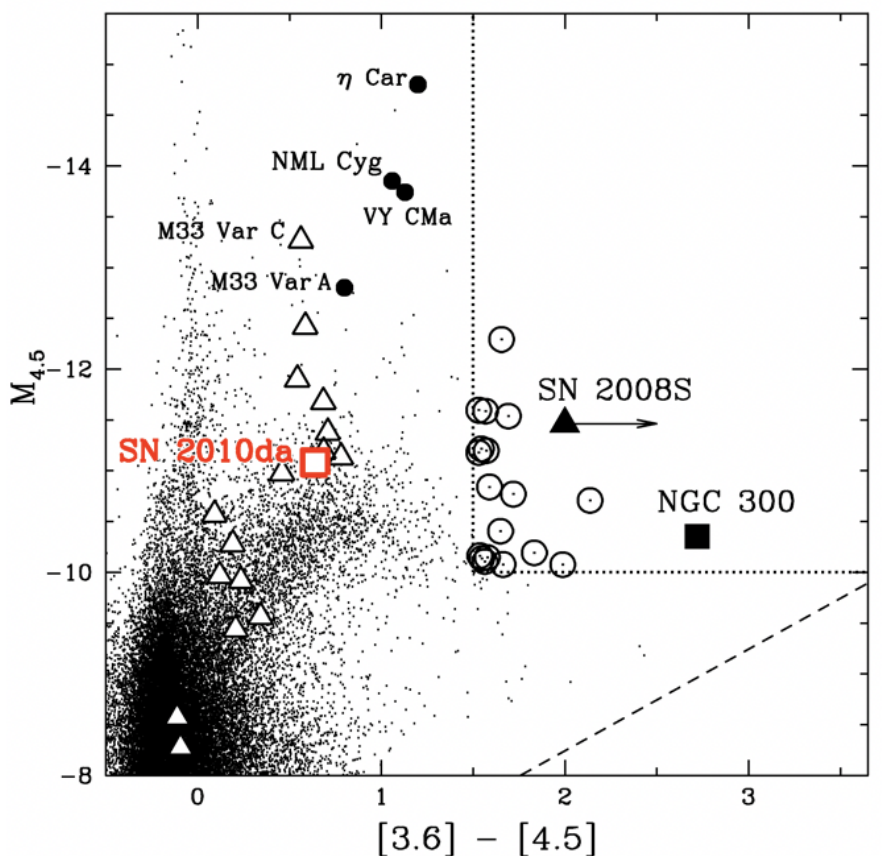
Figure 2. The mid-IR color–magnitude diagram (CMD) showing the SN 2010da progenitor (red square) and local luminous blue variables (LBVs) and LBV candidates (filled circles and triangles, respectively). Open circles and filled triangles show the CMD locations of LBV-like supernova (SN) “impostors.” Reproduced with permission from Khan et al.